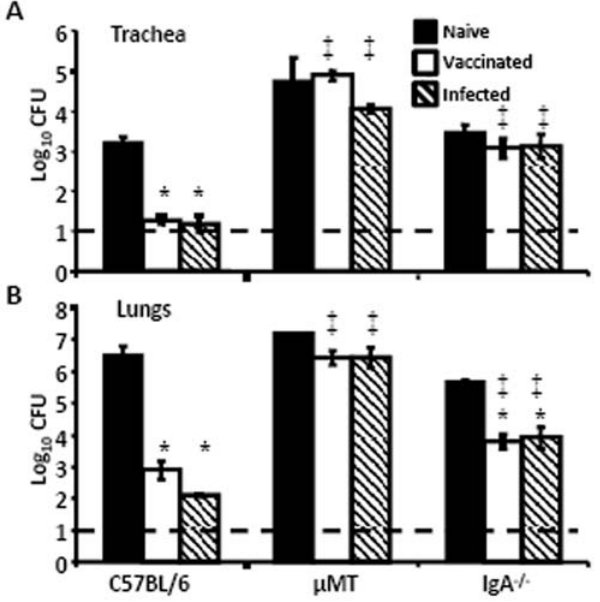
Figure 2. B.bronchiseptica numbers in the LRT of immunized B- cell and IgA deficient mice. Naı¨ve (black bars), B. pertussis -vaccinated (white bars), or B. pertussis -convalescent (hatched bars) C57BL/6, m MT and IgA 2 / 2 mice were dissected Day 3 post gentimicin R B. bronchi- septica challenge. Bacterial numbers in the trachea (A) and lungs (B) are represented as the mean Log 10 CFU + / 2 SEM. Dashed line indicates the lower limit of detection. * indicates statistical difference ( P value , 0.05) between naı¨ve and treated groups. { indicates statistical difference ( P value , 0.05) between mutant mouse and similarly treated wild type mouse groups.